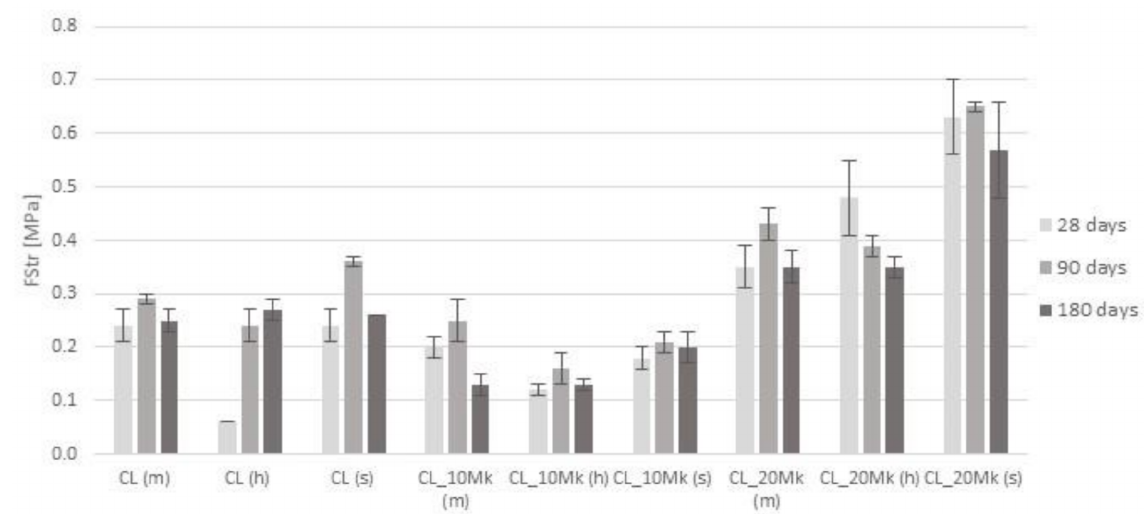
Figure 4. Flexural strength of mortars with 0, 10 and 20% Mk replacing air lime, after 28, 90 and 180 days in maritime, humid and standard curing